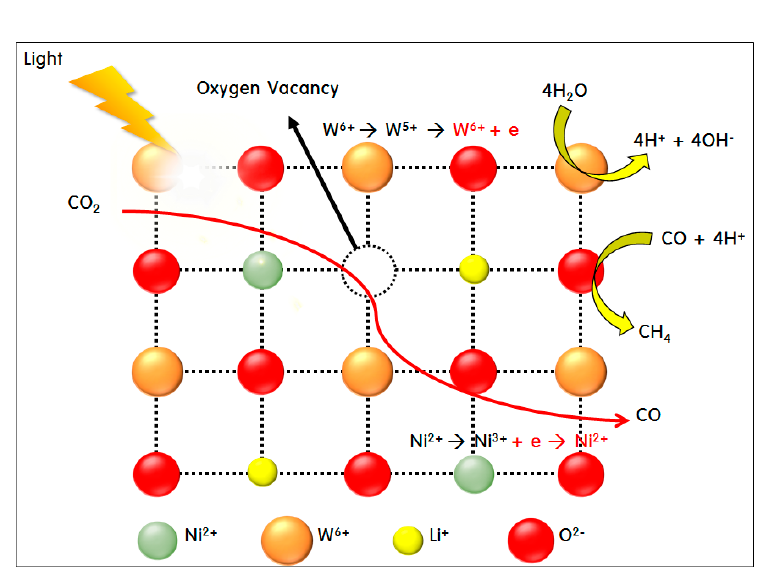
Scheme 1. Mechanism of CO 2 photoreduction on Ni 1-x Li 2x WO 4 under UV irradiation.